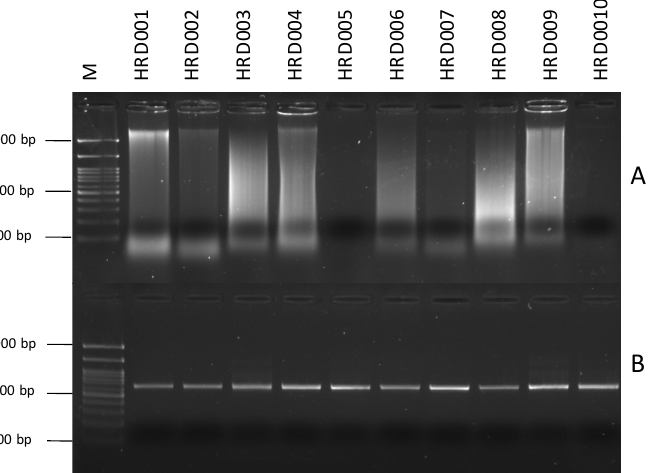
Figure 1. Agarose gel electrophoresis of the genomic DNA from ten single-drug herbal powder samples ( A ) and the PCR amplified rbcL DNA barcode markers ( B ) from the respective samples along with 100 bp DNA ladder (M).